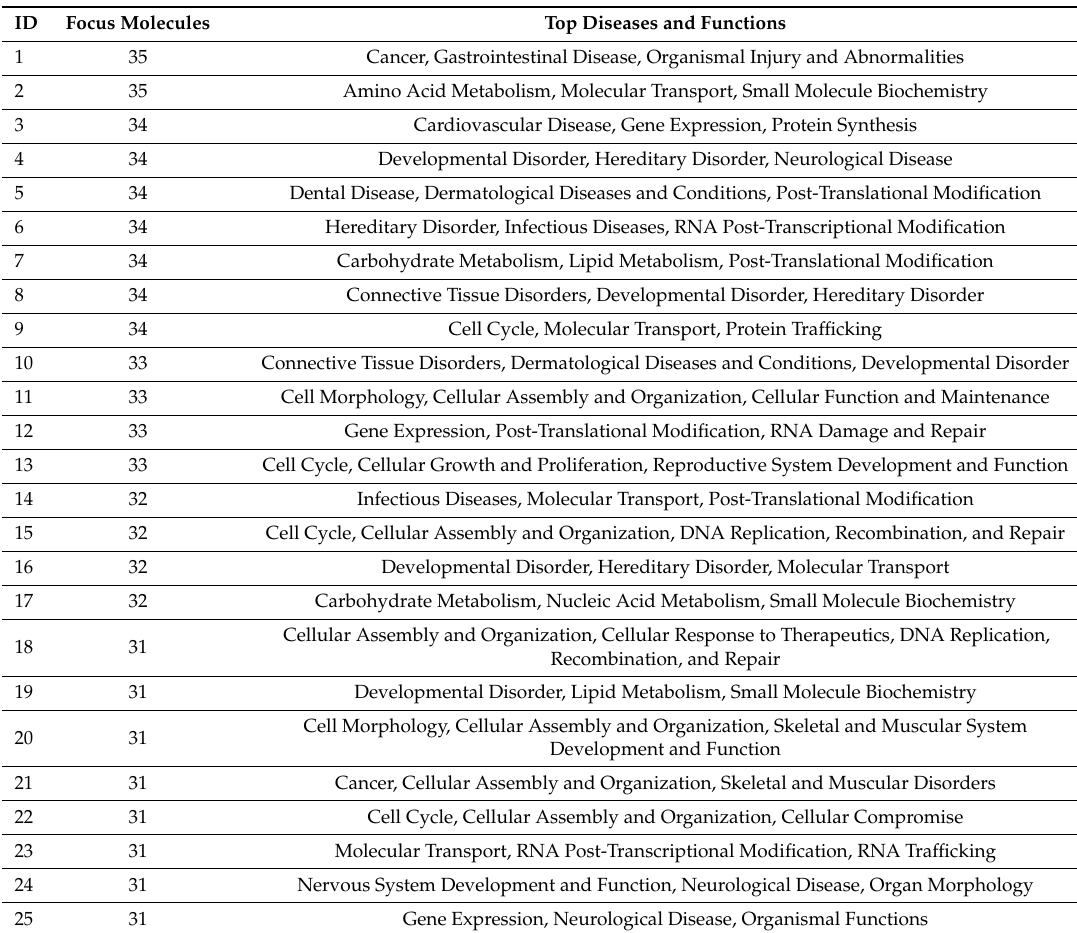
Table 2. Networks generated from genes which have significant di ff erence between intestinal- and di ff use-type gastric cancer (GC). The networks were generated from a total of 2815 probe set IDs di ff erentiated between intestinal-type (CIN; chromosomal instability) and di ff use-type (GS; genomically stable) GC (Student’s t-test, p <